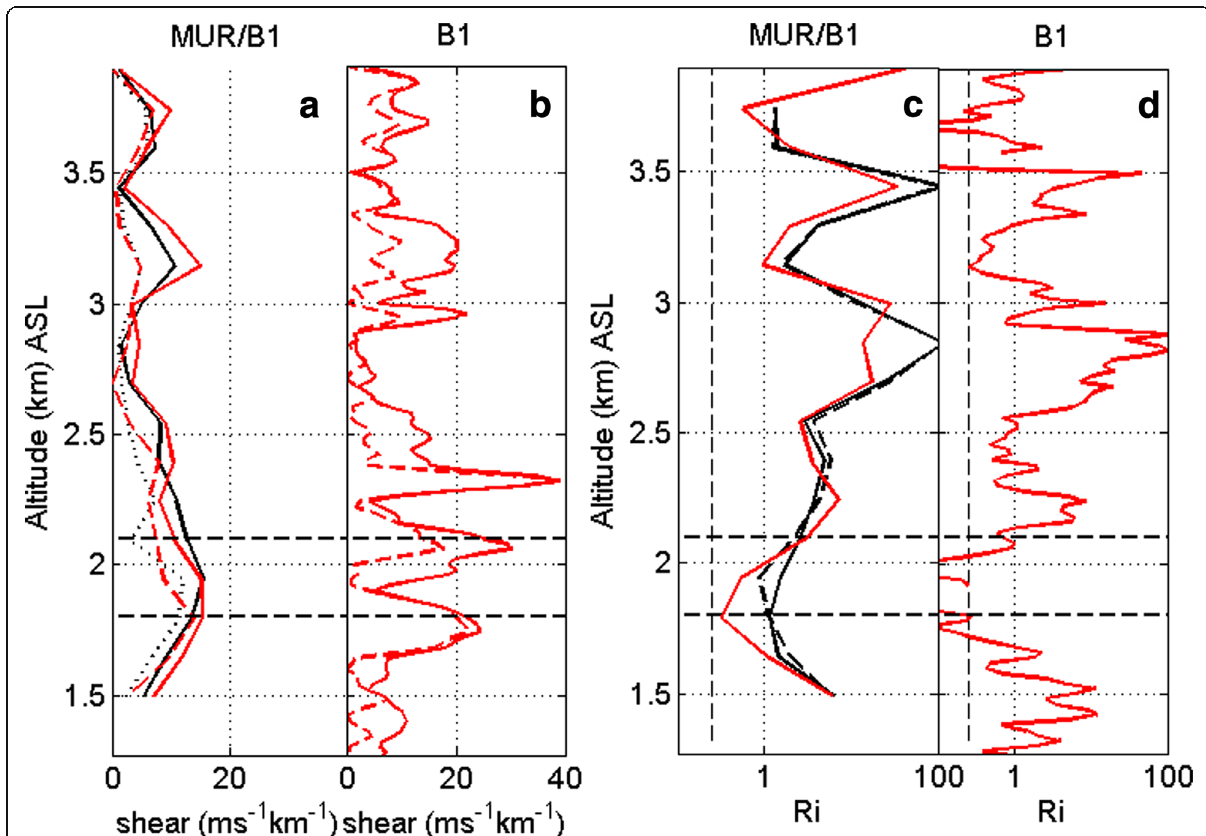
Fig. 5 a Vertical profiles of vertical shears of horizontal wind (solid, wind shear; dashed, speed shear) at a vertical resolution of 150 m from MU radar data (05:40 – 06:40 LT) (black) and B1 data (red). b Same as (a) at a vertical resolution of 20 m from B1 data. c Ri profiles estimated at a vertical resolution of 150 m from B1 data (red) and from MU radar data and N 2 estimated from UAV4A data (black solid) and UAV4D data (black dashed). d Ri profile estimated from B1 data at the vertical resolution of 20 m. The horizontal thick dashed lines delineate the KH region (2). The vertical thin dashed lines show the critical value of Ri